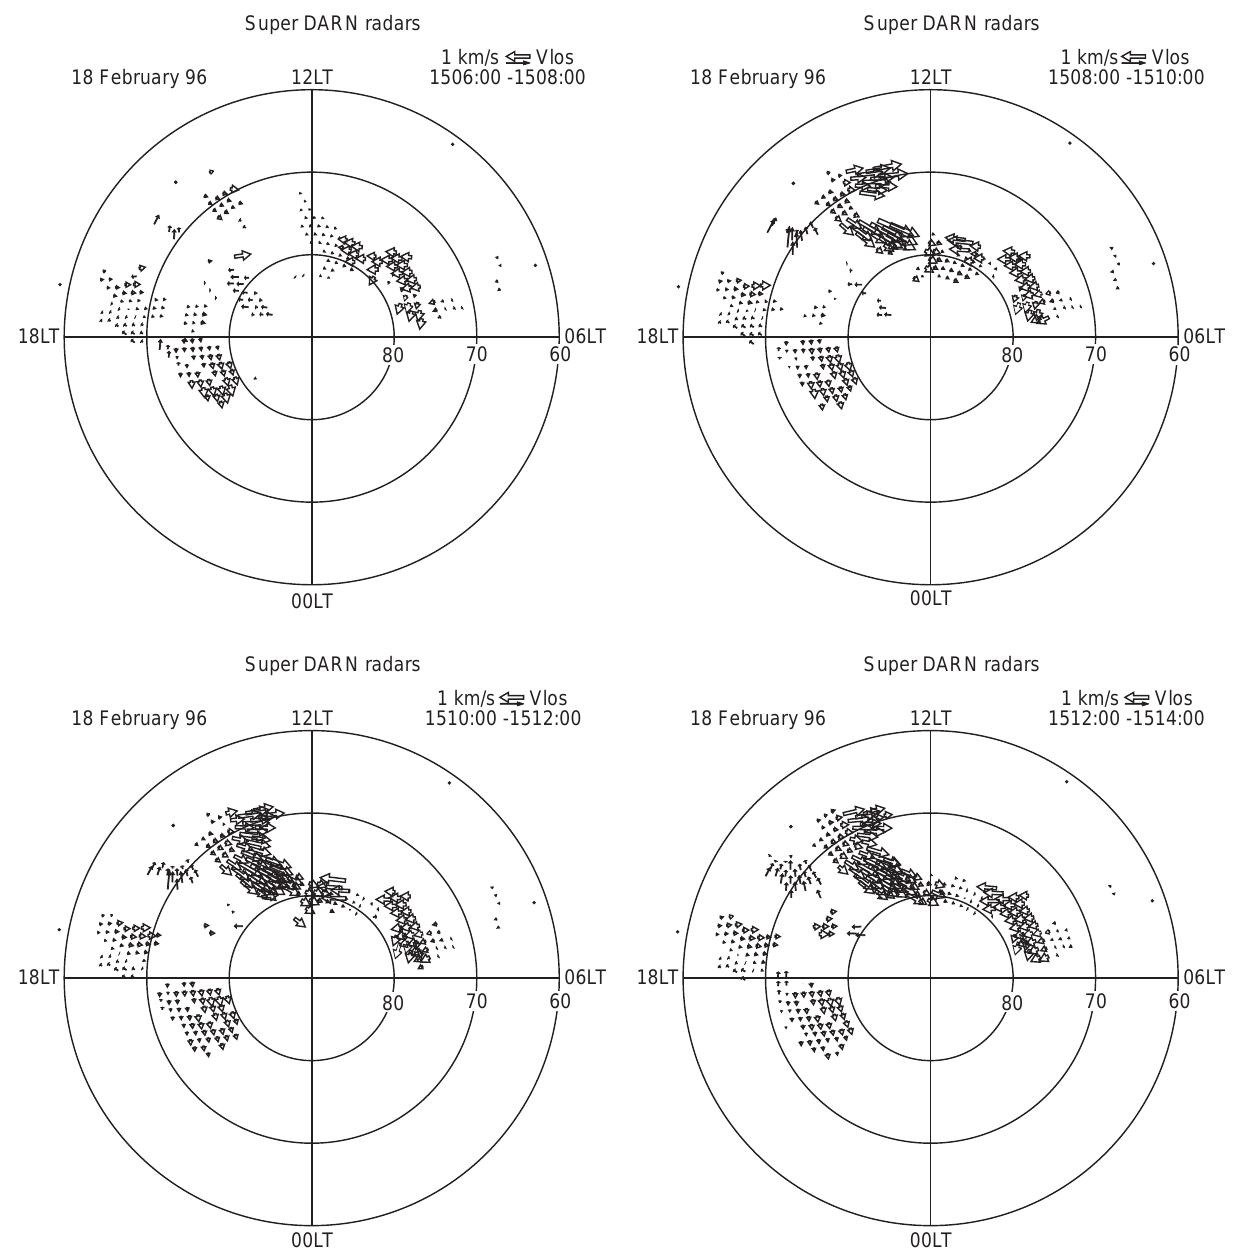
Fig. 3. Line-of-sight velocities measured by five of the SuperDARN radars on February 18, 1996. Note the change in the magnitude of the velocities in the frame that started at